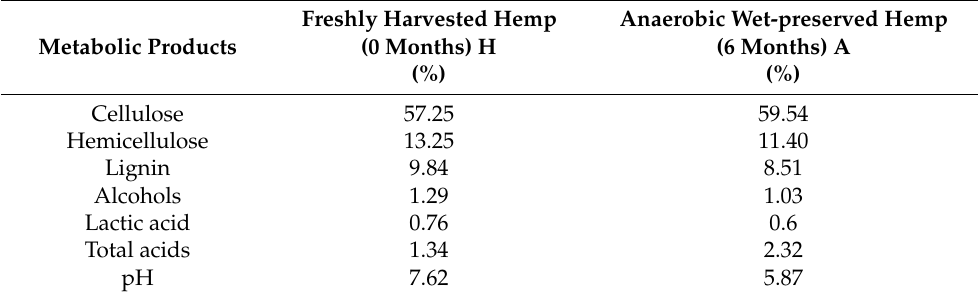
Table 1. Proportion of structural polymers, content of metabolic products and pH in freshly-harvested (H) and anaerobic wet-preserved hemp (A). Data taken from [107]. Freshly Harvested Hemp Metabolic Products (0 Months)